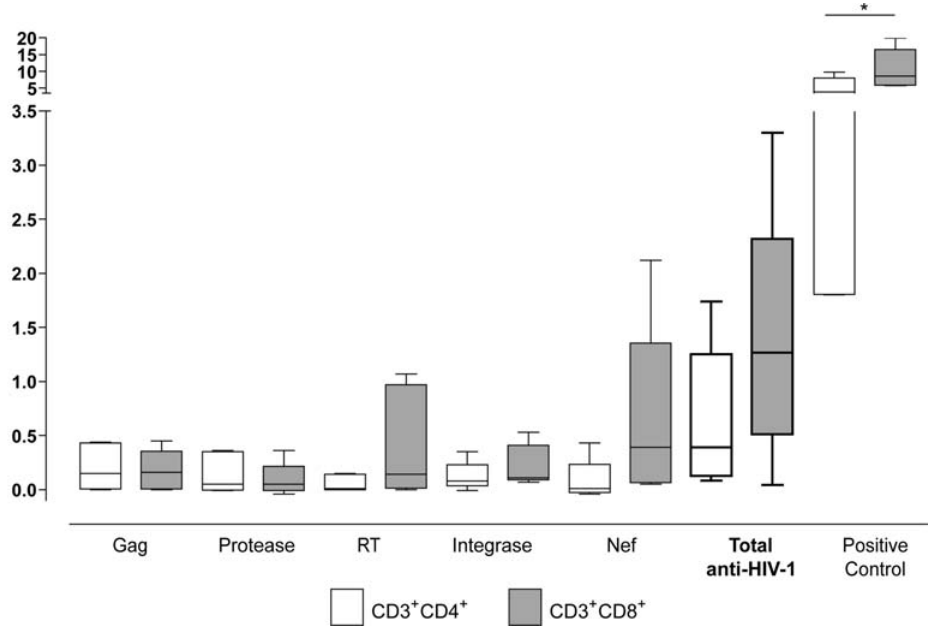
Figure 4. IFN- c responses are derived from both CD4 + and CD8 + T cells. CD4 + (open boxes) and CD8 + (shaded boxes) T cell IFN- c responses towards HIV-1 derived peptide pools Gag, Protease, RT, Integrase and Nef, plus the cumulative anti-HIV-1 response and a SEB positive control. No significant difference was observed between the two T cell subsets (n=5).